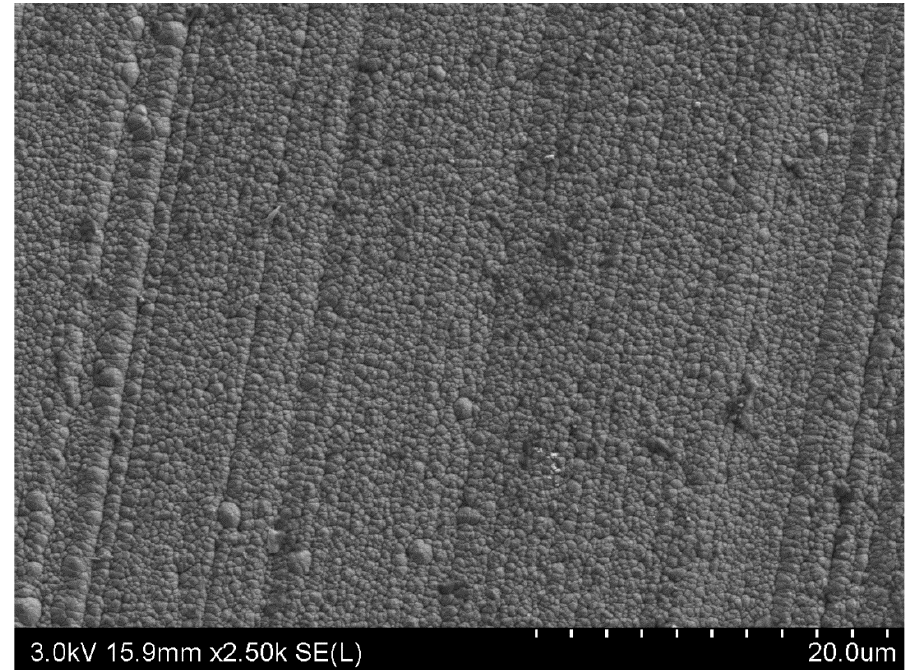
Figure 5. SEM image of the “AlTiN” coating (Hitachi SU-70 scanning electron microscope).